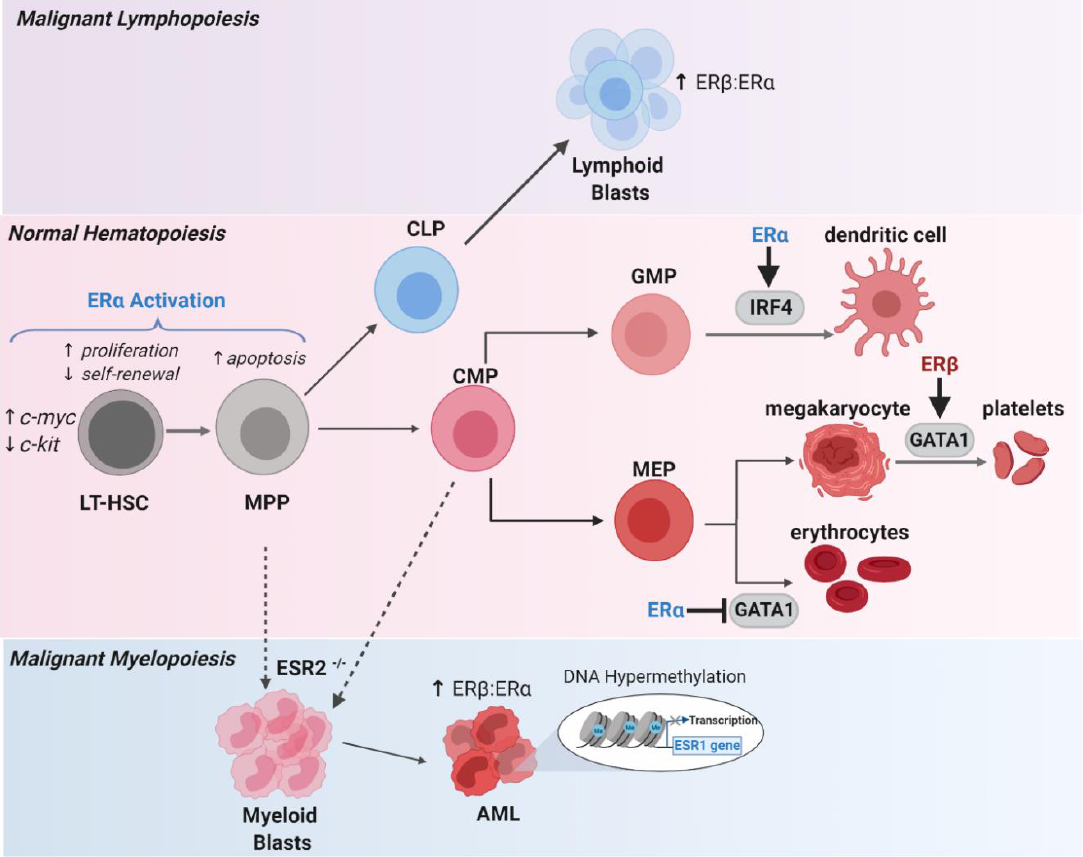
Figure 1. The role of estrogen receptors in hematopoiesis and acute myeloid leukemia (AML). In hematopoiesis, the activation of ER α by estradiol or tamoxifen increased proliferation and decreased self-renewal of primitive long-term hematopoietic stem cells (LT-HSC). The upregulation of c-myc and downregulation of c-kit upon ER α activation contributes to this phenotype. Multipotent progenitors (MPP) undergo apoptosis while ER α -mediated activation of IRF4 encourages dendritic cell di ff erentiation. Additionally, ER α -mediated inhibition of GATA1 increases erythropoiesis while the ER β -mediated activation of GATA1 results in increased megakaryocyte polyploidization to produce platelets. In malignancy, lymphoid-related cancers predominantly express the ER β subtype and its activation inhibits tumor growth. The knockdown of ESR2, the gene encoding ER β , leads to a myeloproliferative disease in mice resembling chronic myeloid leukemia. The possible origins of this disease are unknown and thus symbolized by dashed arrows. In AML, the DNA hypermethylation of ESR1 is prominent among patients and results in decreased transcription of ER α . ER α hypermethylation often co-occurs with the methylation of other tumor suppressor genes, which also influences patient prognosis and the response to hypomethylating agents. A subset of AML patients also express increased ER β compared to ER α , and it has been shown that this subset would best be targeted by an ER β